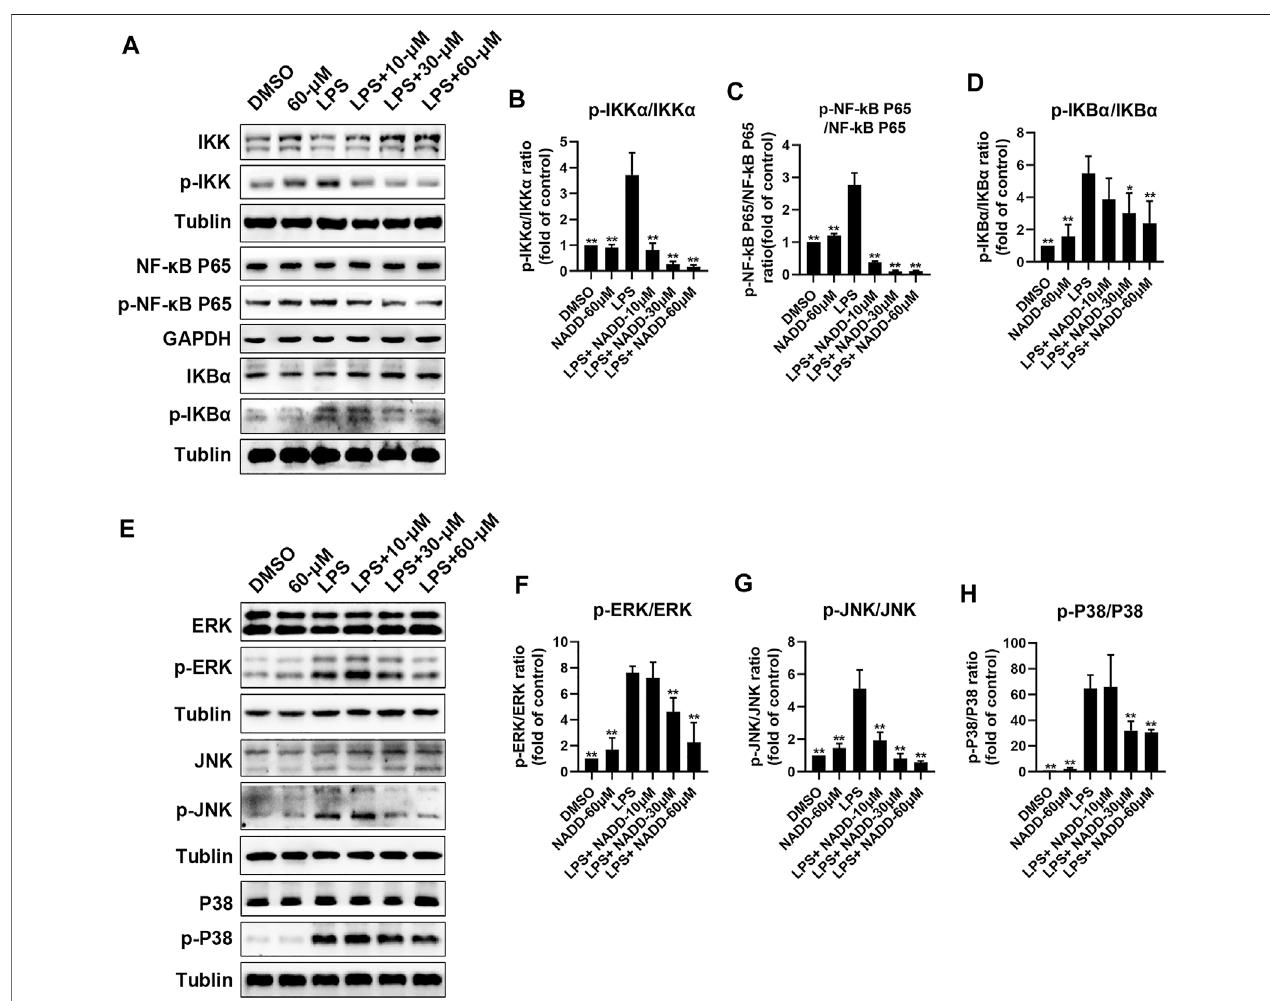
FIGURE6| ProteinlevelsofNF-kBandMAPKpathwayfactorsafterLPSandNADDtreatments. (A) ExpressionofIKK,p-IKK(LPSstimulated30 min),NF-kBp65, p-NF-kB p65 (LPS stimulated 60 min), IKB α and p-IKB α (LPS stimulated 60 min) in the NF-kB pathway. Tubulin were internal reference proteins. Bar charts showing expression of p-IKK/IKK (B) , p-NF-kB p65/NF-kB p65 (C) and p-IKB α / IKB α (D) . (E) expressions of ERK, p-ERK (LPS stimulated 15 min), JNK, p-JNK (LPS stimulated 30 min), P38 and p-P38 (LPS stimulated 30 min) in the MAPK pathway; Tubulin was the internal reference protein; Bar charts showing expression of p-ERK/ERK (F) , p-JNK/JNK (G) and p-IKB α /IKB α (H) . Differences were statistically signi fi cant when compared with the LPS treated cells (* p < 0.05, ** p <